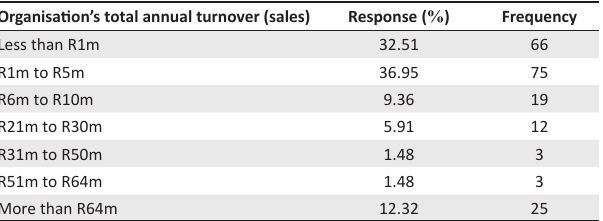
TABLE 5: Percentage response and frequency of total annual turnover ( N = 203).